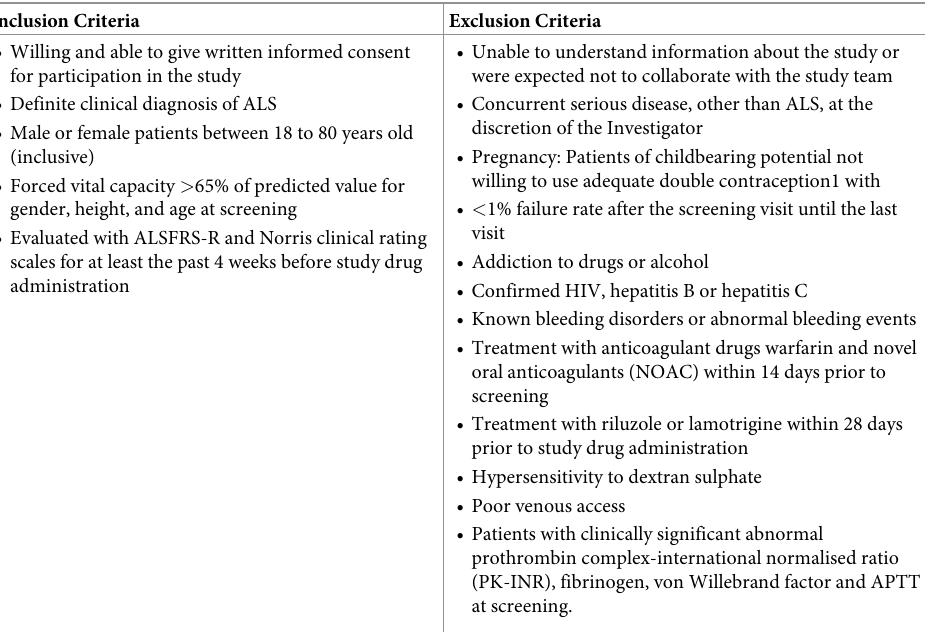
Table 1. Trial inclusion and exclusion